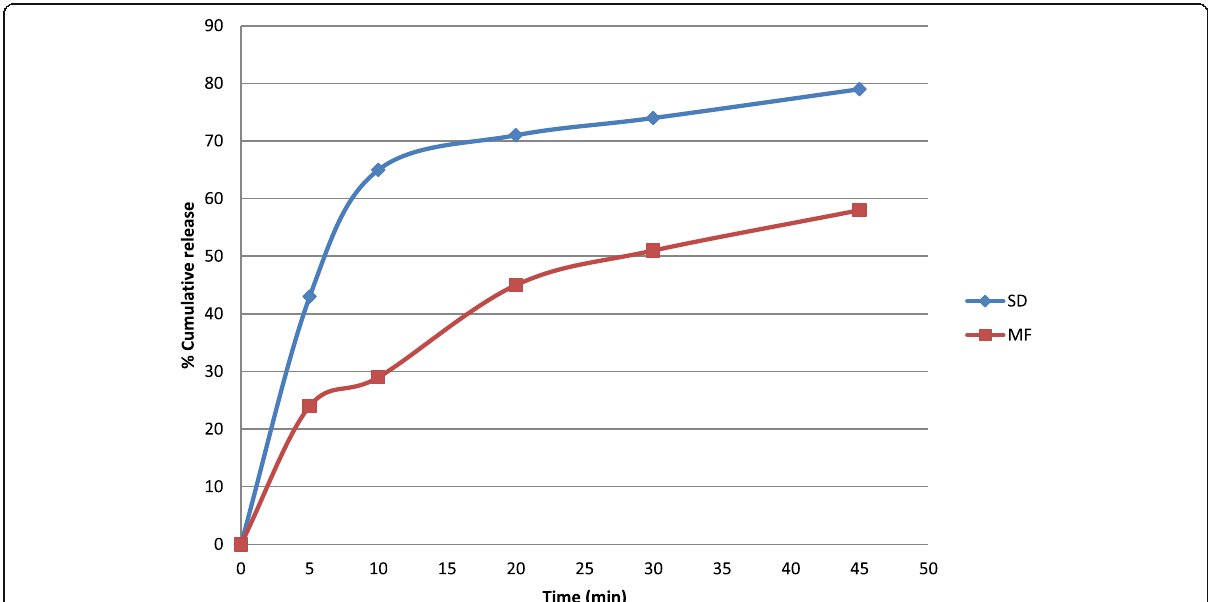
Fig. 4 Cumulative in vitro release of Orlistat form prepared solid dispersion. *SD represents prepared Orlistat solid dispersion and MF represents marketed